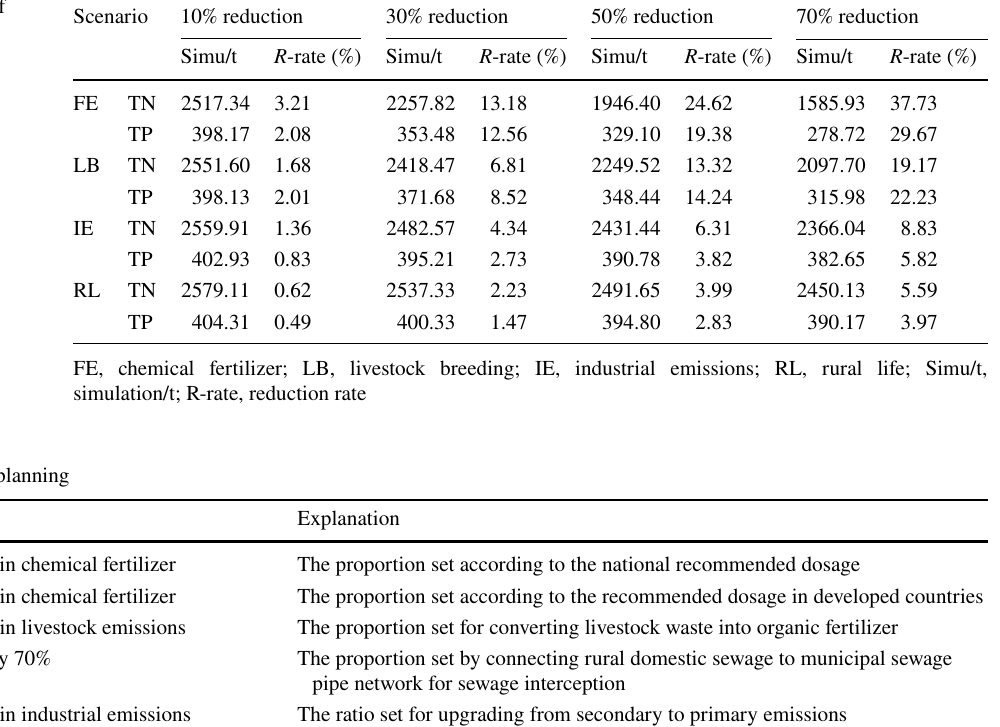
Table 3 Simulation results of various measures